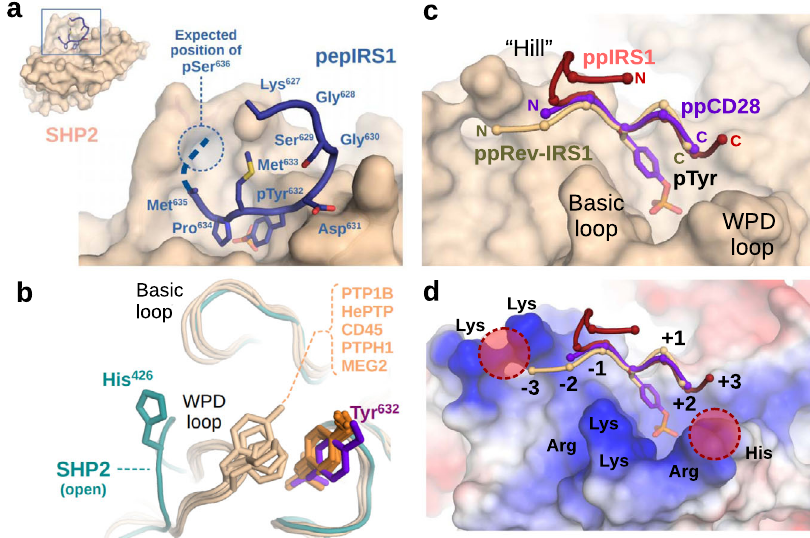
Fig. 4 | Crystal structures of SHP2 with dually phosphorylated peptides. a OverviewoftheSHP2-ppIRS1(pY632-pS636)complex,withallaminoacidsofthe duallyphosphorylatedsubstrateseenintheX-raystructure.Theexpectedposition ofpSer636isalsoindicated. b Ourstructuresdifferfrommostotherphosphatases, such as PTP1B (pdb:1EEO), HePTP (pdb:3D42), CD45 (pdb: 1YGU), PTPH1 (pdb:4QUM) and MEG2 (pdb:4ICZ) as having an open catalytic WPD loop